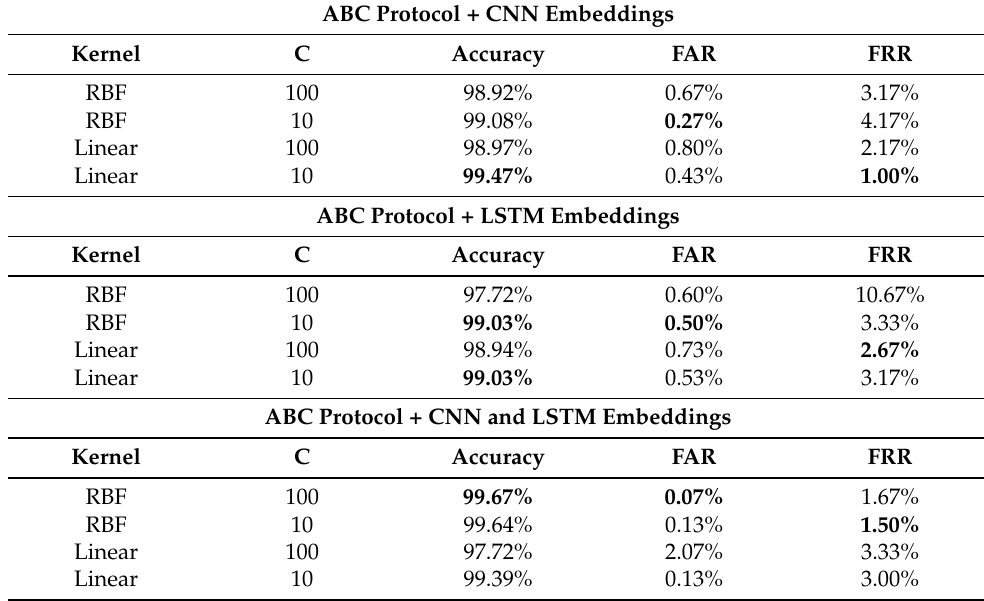
Table 3. Accuracy, FAR and FRR of the multi-modal ABC protocol for the attack scheme proposed in [13], when five images and motion signals are used during registration and authentication. Results are reported for binary SVM classifiers based on neural embeddings from a CNN, a ConvLSTM or both. For each neural embedding type, we consider two kernels and different values for the regular- ization parameter C . All reported metrics represent average values computed for six smartphone devices, with 100 authentic sessions and 500 attack sessions per device. For each neural embedding type, the best results are highlighted in